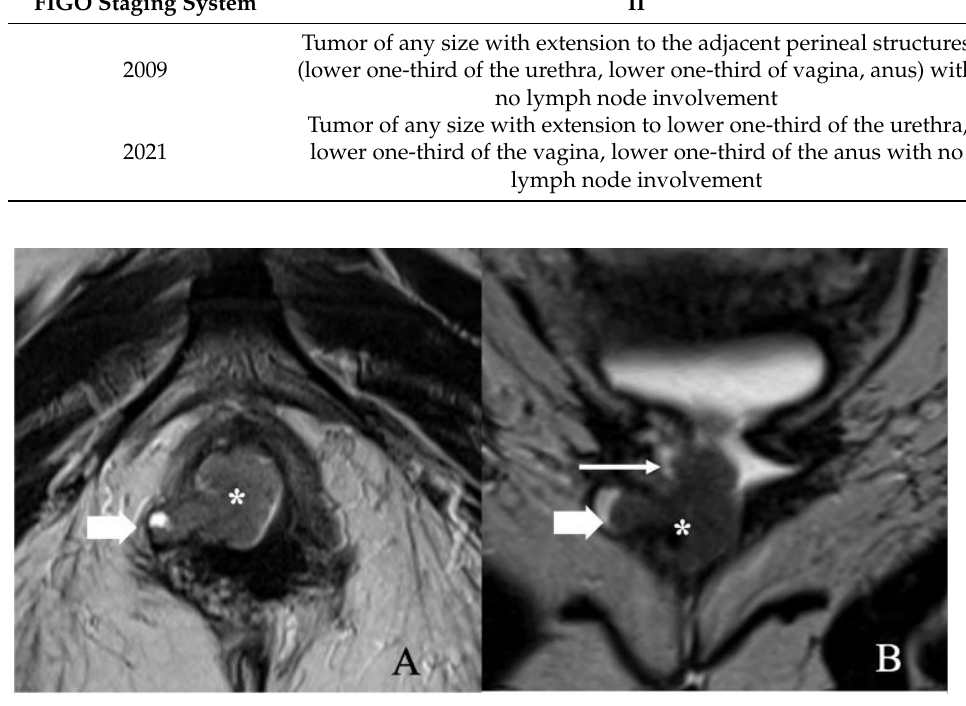
Figure 5. FIGO stage II. A 57-year-old female with squamous cell carcinoma of the vulva. ( A ) Axial T2 weighted image and ( B ) coronal T2 weighted MRI image show a 3.4 × 1.4 cm vulvar tumor (asterisk) involving the right aspect of the lower one-third of the vagina (long thin arrow) and right ischio-anal fossa (short thick arrow). Anteriorly, the mass abuts the lower third of the urethra. No lymphadenopathy was noted. Note that the gel in the vagina helps better delineate the